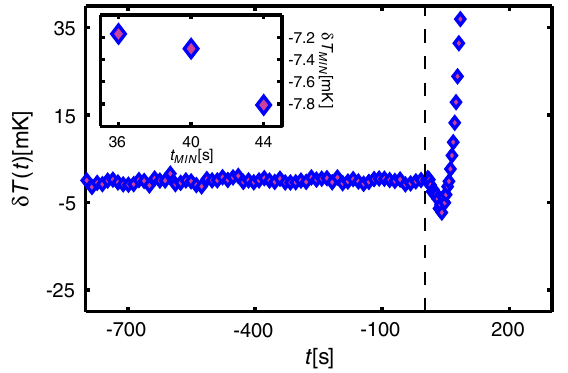
FIG. 12. The temperature at the center of a sphere of glucose, with diameter 19 mm. At time t ¼ 0 s a step in temperature from 298 to 303 K is applied with the cryostat (see the setup in Fig. 11). The temperature drops initially by 7.3 mK as result of cooling by heating. The inset shows the minimum temperature (cid:5)T reached in three measurements, on three different MIN samples, at the same